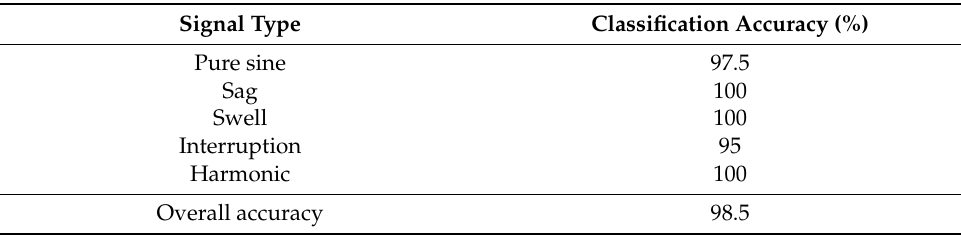
Table 9. Classification accuracy using the real